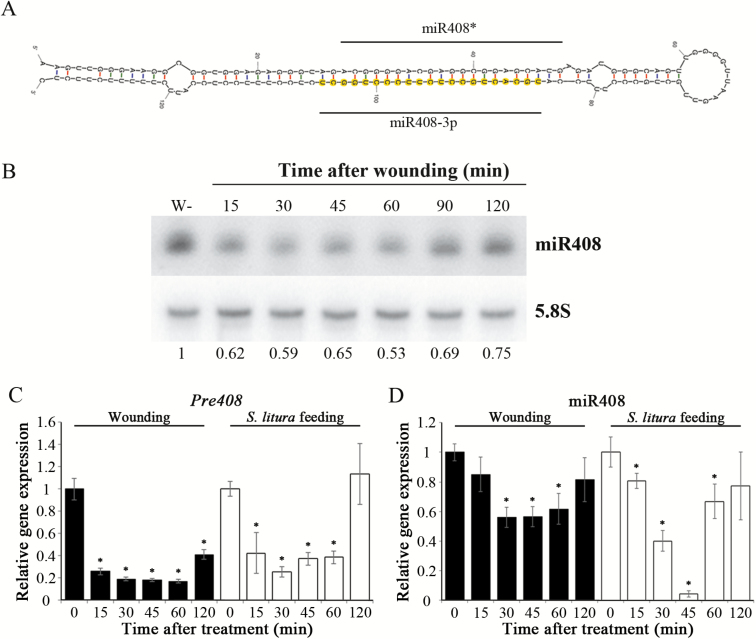
Expression patterns of miR408 precursor (pre408) and miR408 in response to wounding. (A) The secondary structure of pre408 in sweet potato. (B) Expression patterns of miR408 in sweet potato upon wounding were analyzed by northern blotting. Total RNAs were extracted from the leaves wounded for 0 (W–), 15, 30, 45, 60, and 120 min. Northern blotting was used to determine the expression levels of miR408. The expression levels of miR408 were normalized by those of 5.8S rRNA. The expression patterns of pre408 (C) and miR408 (D) in the leaves of sweet potato wounded by mechanical wounding or insect feeding for 0, 15, 30, 45, 60, and 120 min were analyzed by qRT-PCR. The qRT-PCR results were normalized by the expression levels of IbActin. Data are presented as means ±SD (n=4). The asterisks represent a significant difference from unwounded treatment by Student’s t-test (*P<0.05).